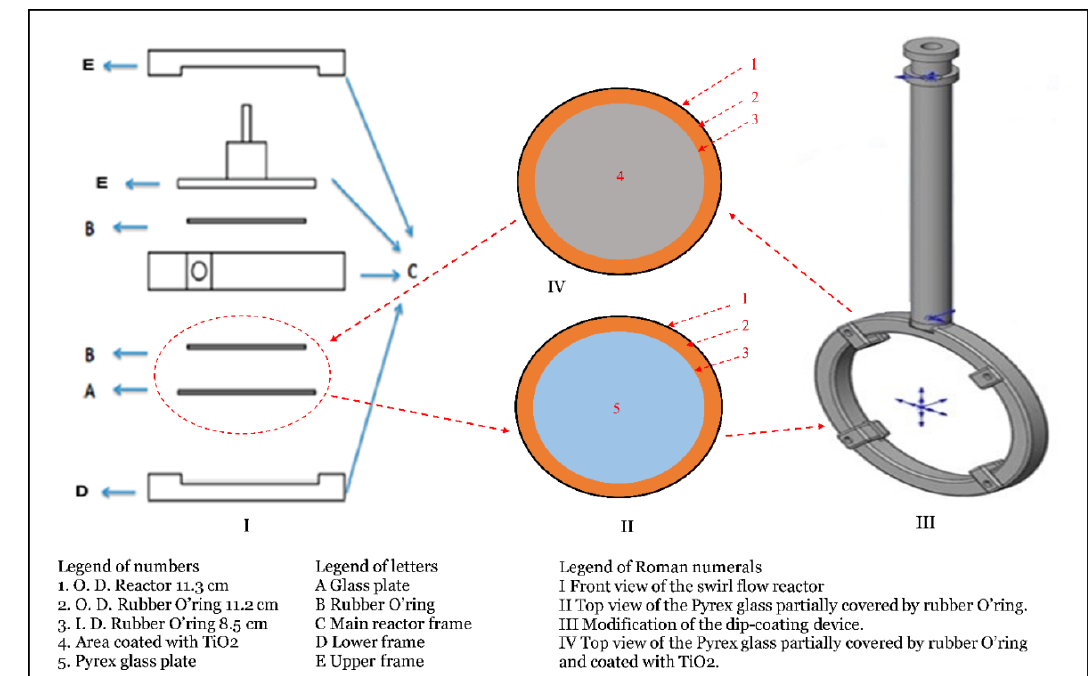
Figure 4. A graphical representation of the approach used for the Pyrex glass